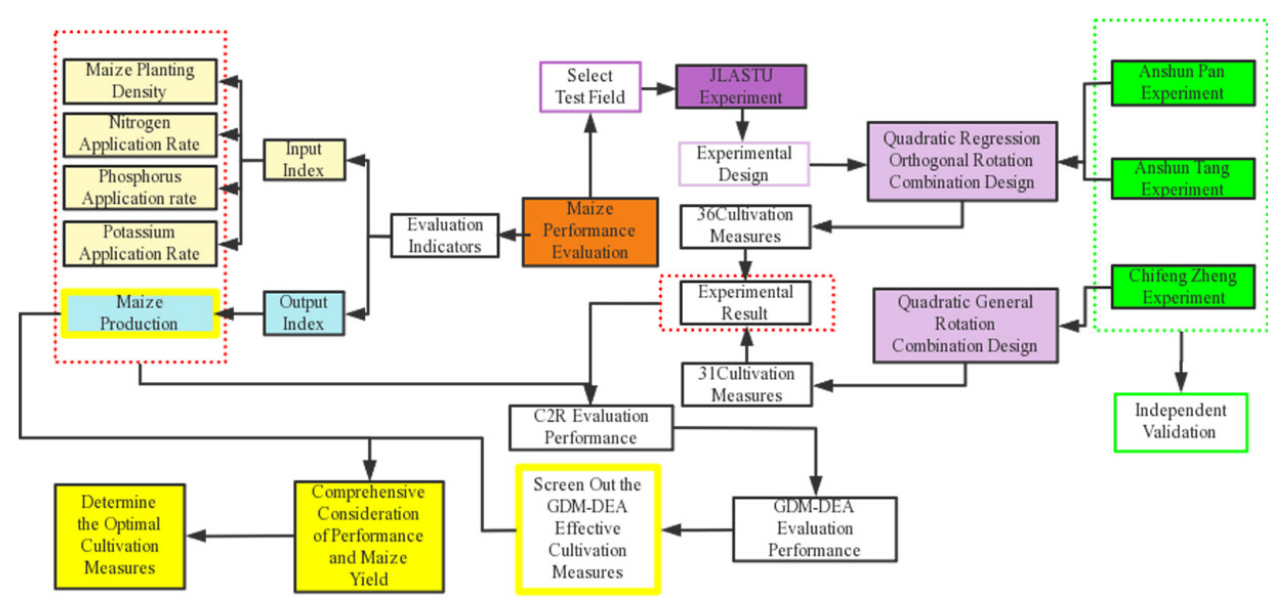
Figure 1. Research Figure 1. Research workflow.